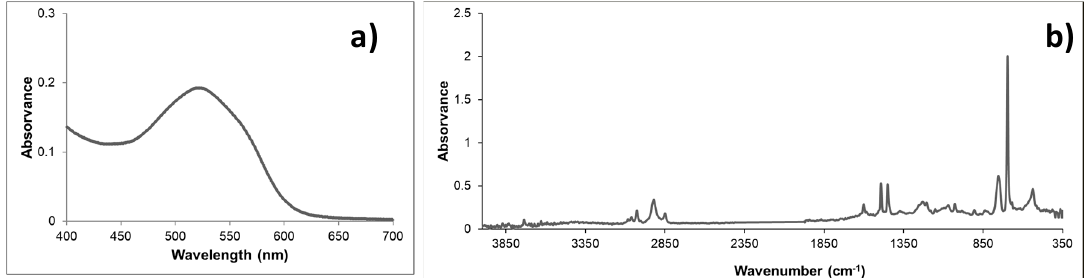
Figure 1. UV–Vis ( a ) and Fourier transform infrared spectroscopy ( b ) spectra of polystyrene nanoplastics dispersion.